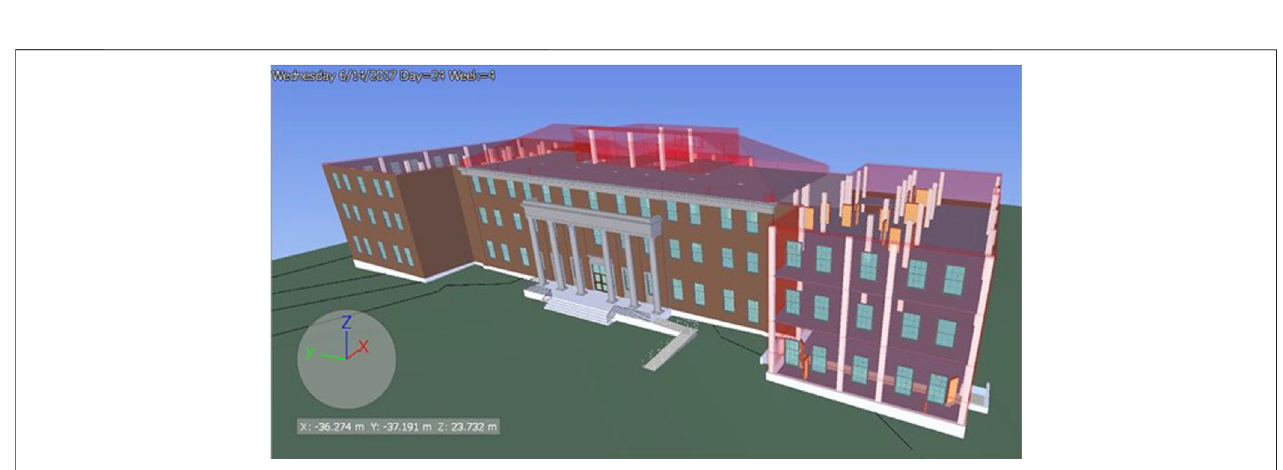
FIGURE 5 | Navisworks Manage and the integration process of the 3D model and schedule.